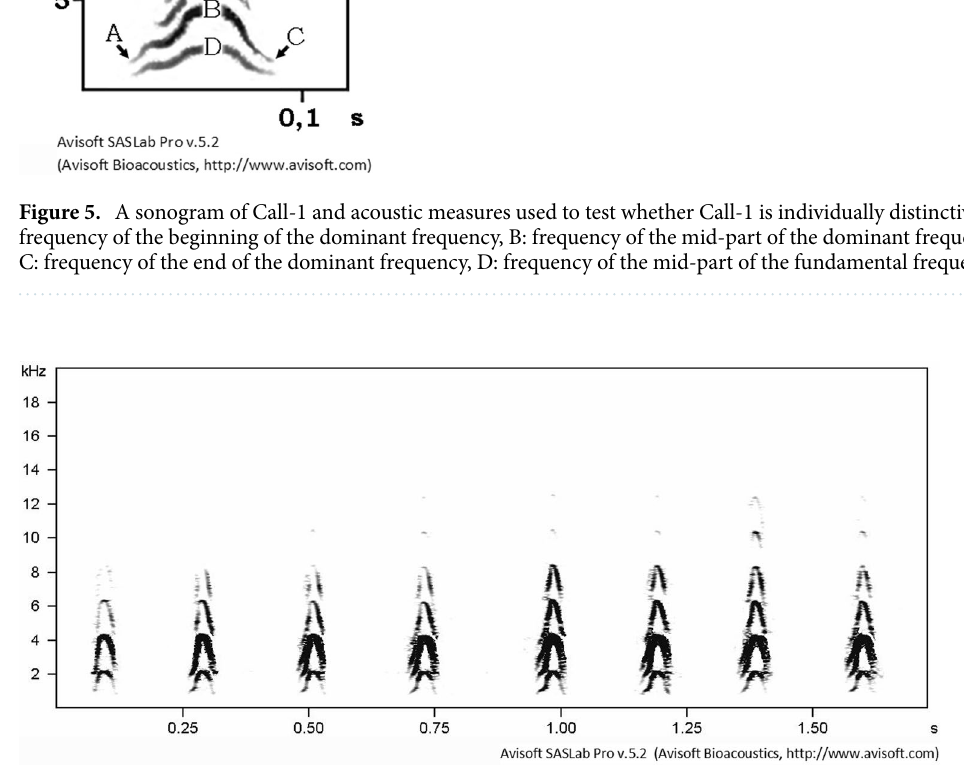
Figure 6. A sonogram of Call-1 uttered in a